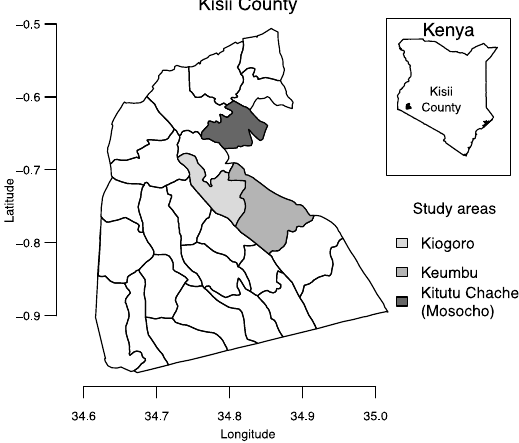
Figure 1. Kisii County with the study areas of Keumbu, Kiogoro, and Kitutu Chache (which includes Mosocho as a smaller area within Kitutu Chache). Shapefiles were obtained from DIVA-GIS (diva-